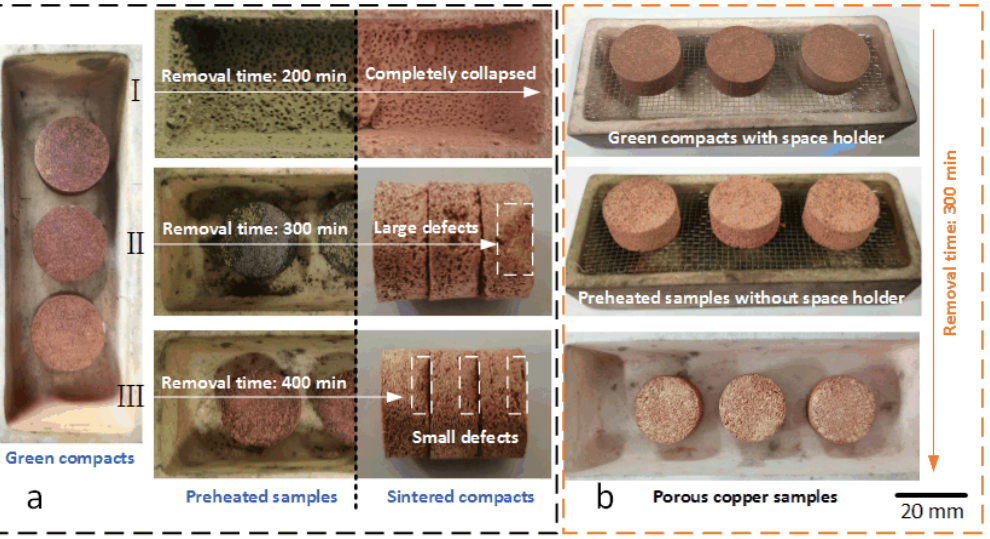
Figure 2. Comparison in thermal removal results of green compacts placed on different substrates: ( a ) An alumina plate and ( b ) a layer metal mesh. ( a ) An alumina plate and ( b ) a layer metal